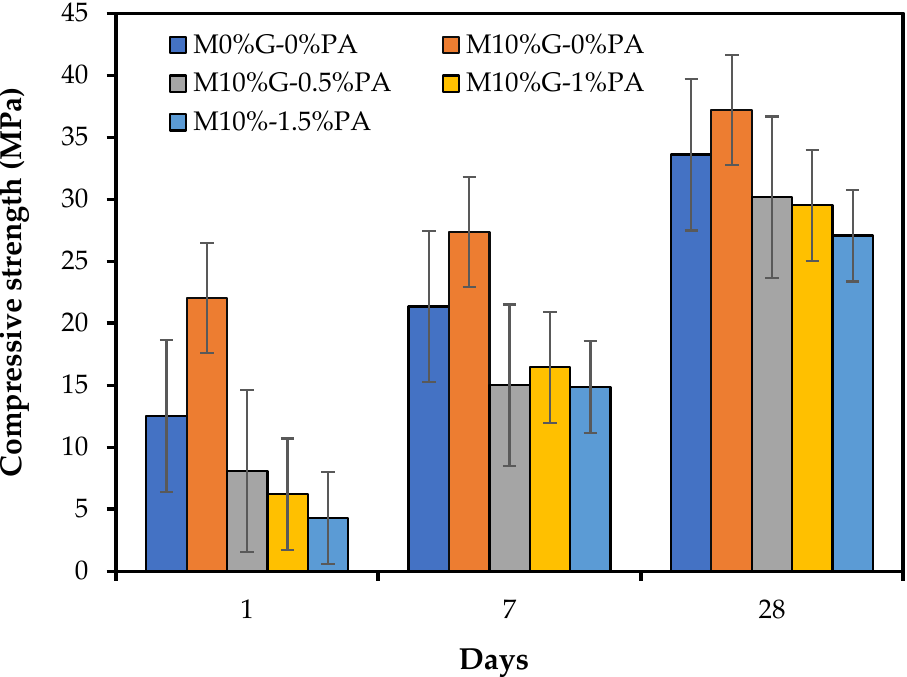
Figure 8. Compressive strength for cubes with powder glass and PA fibers (6 cubes/mix).